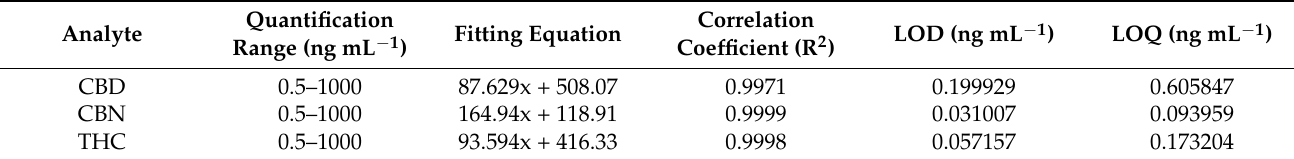
Table 4. Linear calibration curves for determination of linear range, correlation coefficient, LOD and LOQ.